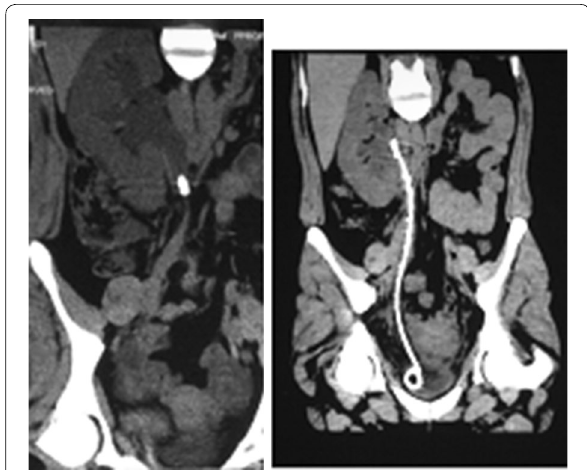
Fig. 1 Forty‑year‑old male patient presented with right upper ureteral stone (1.7 cm). Stone disintegration was performed using semirigid URS and laser lithotripsy. JJ stent was placed at the end of the